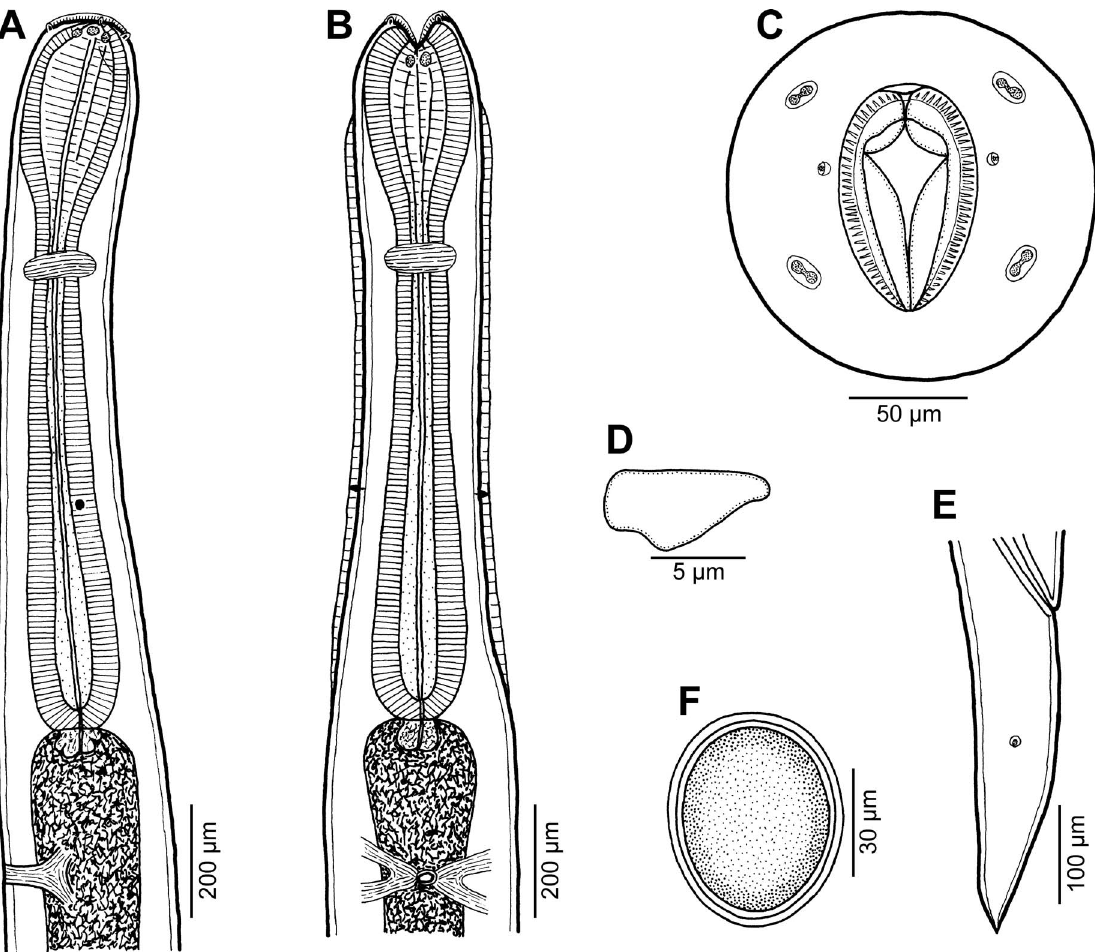
Figure 7. Cucullanus incognitus n. sp. from Dentex fourmanoiri , female. (A, B) Anterior end of body, lateral and ventral views; (C)